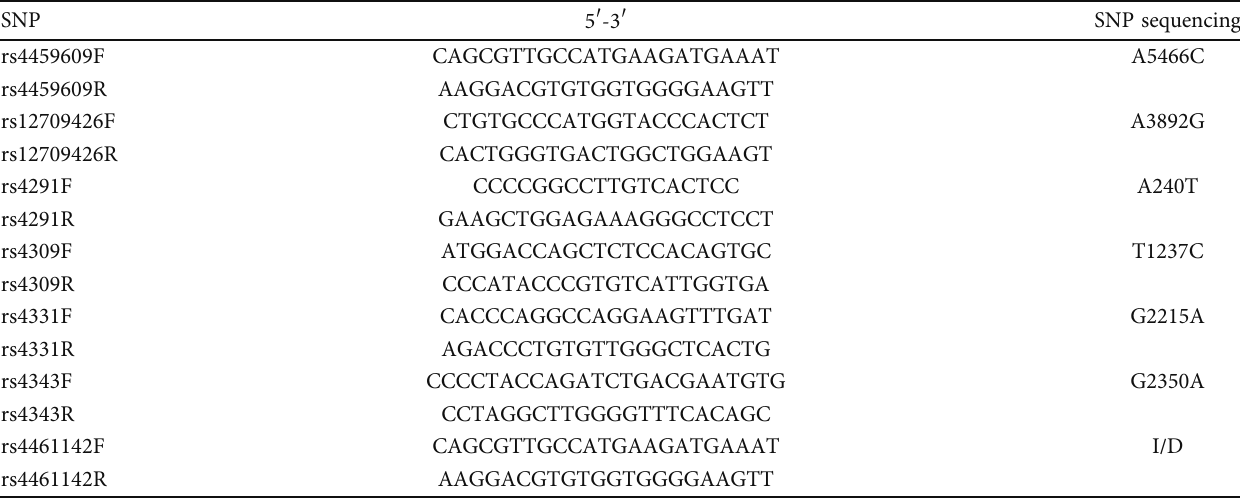
Table 1: Oligonucleotide primers used for the multiplex PCR ampli fi cation of the ACE gene.